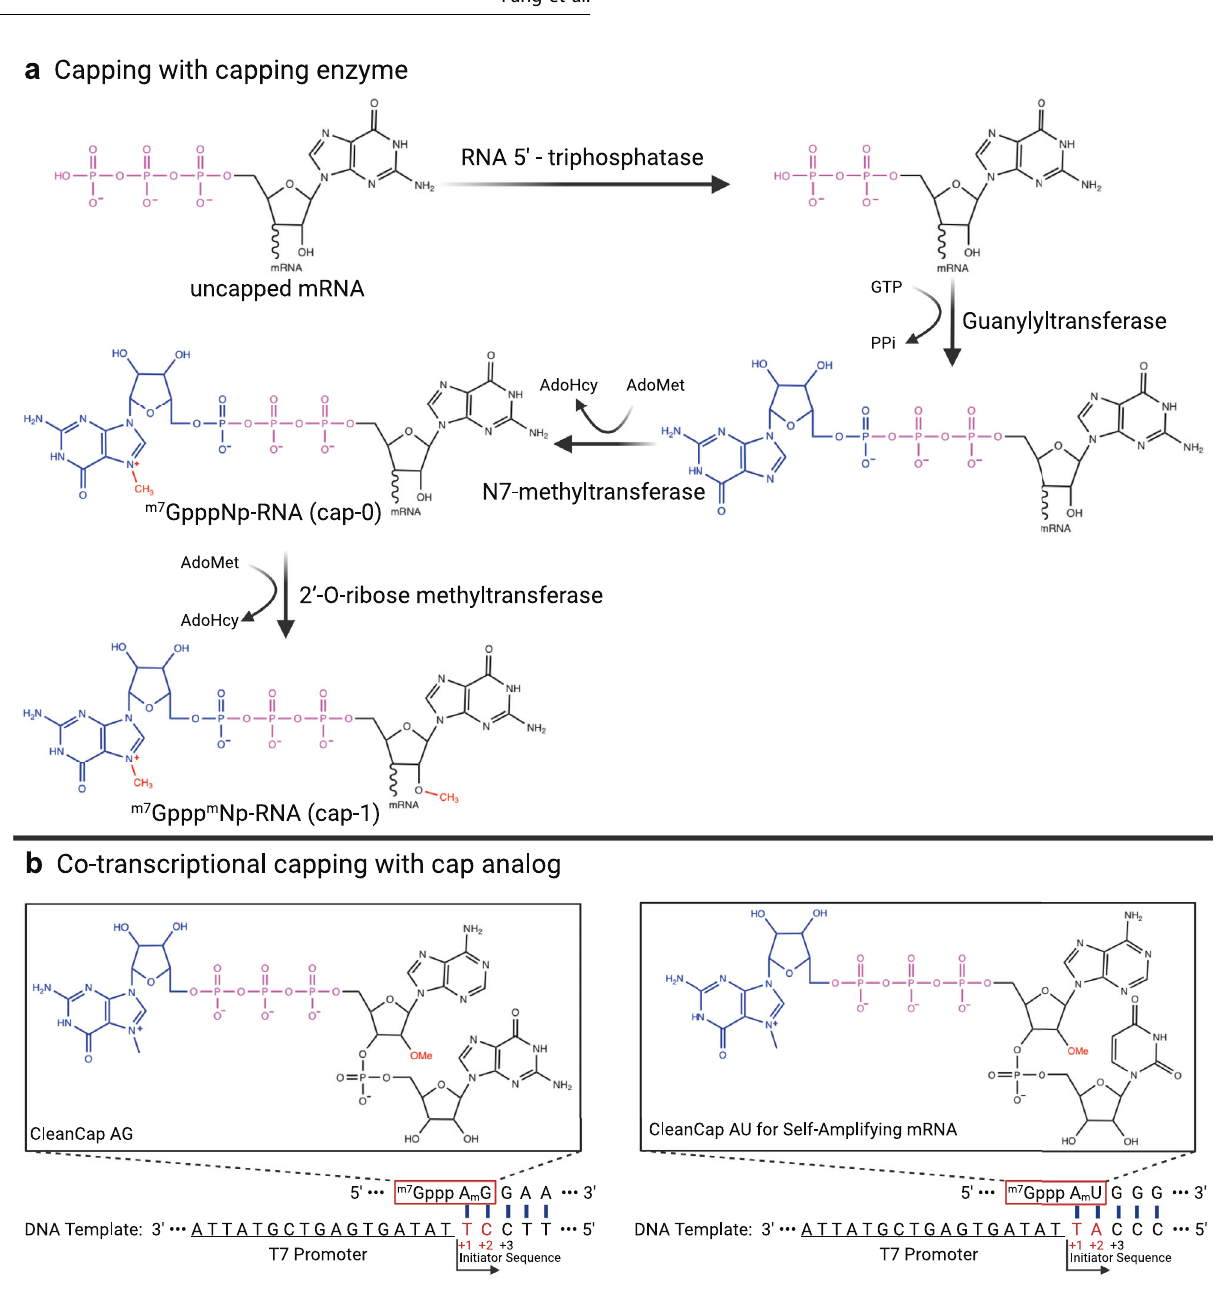
Fig. 5 mRNA capping procedure using capping enzymes or cap analogs. A Production of post-transcriptional modi fi cations of mRNA with cap0 requires three enzymes: triphosphatase, guanylyltransferase, and N7-methyltransferase with S-adenosylmethionine (SAM) as the